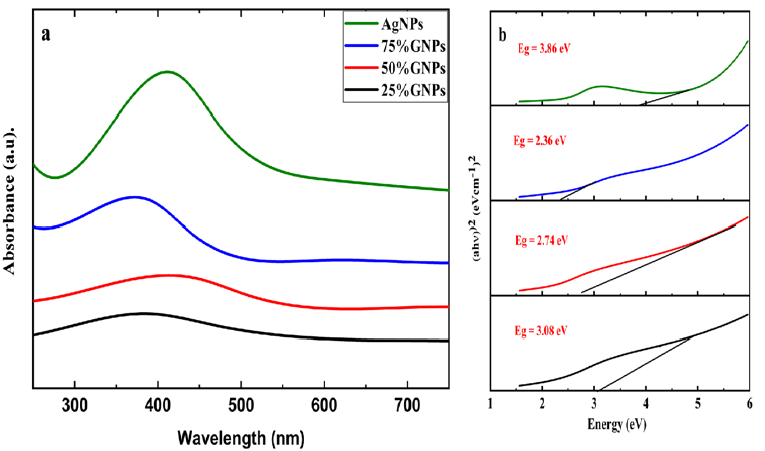
Figure 1. UV - Vis analysis of ( a ) AgNPs and GNP - Ag nanocomposites; ( b ) calculated energy Figure 1. UV-Vis analysis of ( a ) AgNPs and GNP-Ag nanocomposites; ( b ) calculated energy bandgaps bandgaps of AgNPs and Ag - GNPs nanocomposites. of AgNPs and Ag-GNPs